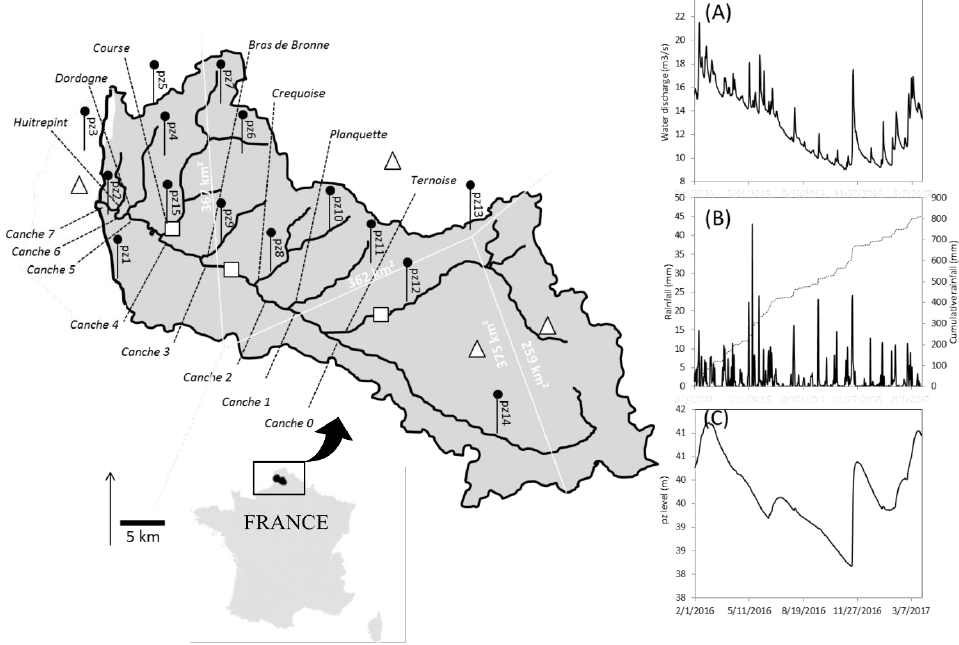
Figure 1. Map of the study area with the Canche River and its main tributaries. Dashed lines point to surface water sampling locations and filled black circles denote ground water sampling locations. The positions of rainfall gauges and discharge gauges are shown as triangle and square markers, respectively. White lines refer to the boundaries between Thiessen polygons used to determine the average rainfall on the catchment. ( A ) Time series of the water discharge (m 3 s −1 ) at the gauging station on the main stream (data from Water Agency Artois-Picardie); ( B ) average rainfall (mm) on the catchment (data from Météo France); and ( C ) piezometric level (m) at pz 10 (data from Water Agency Artois-Picardie).